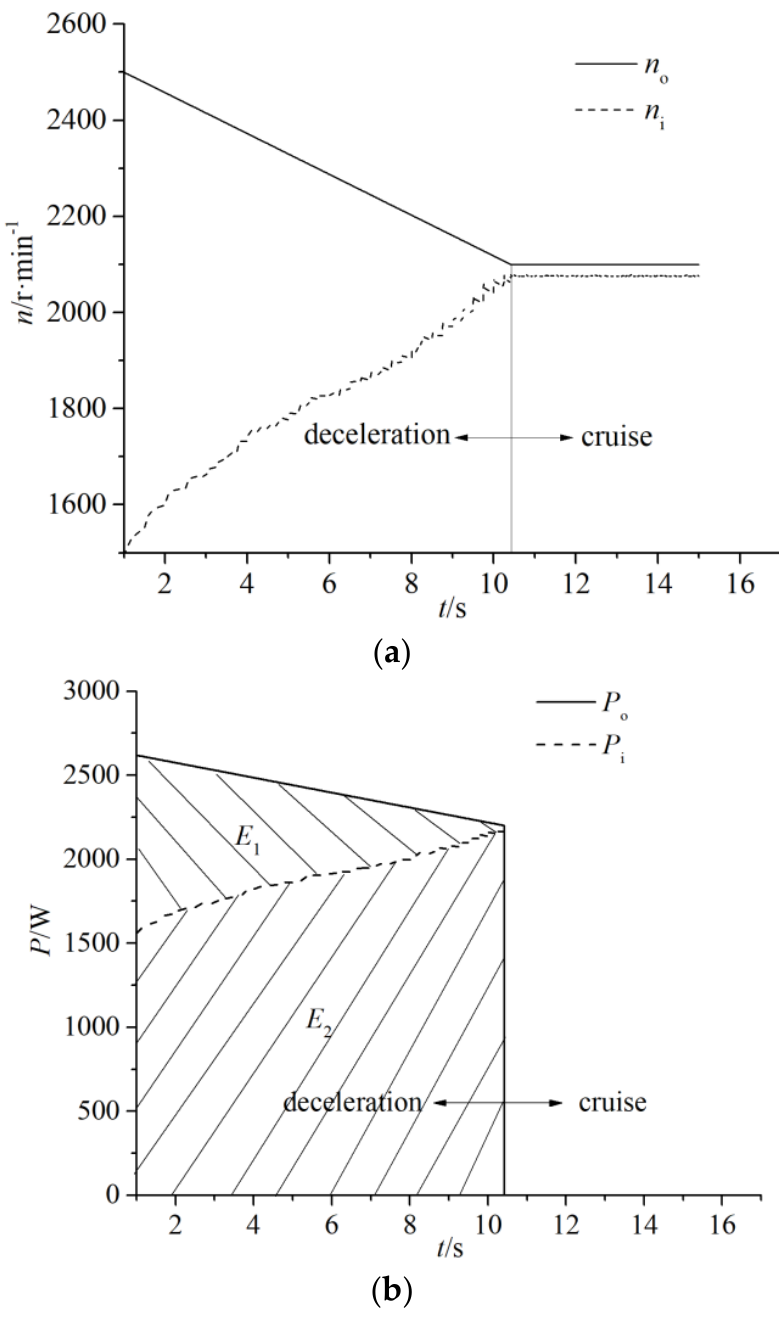
Figure 9. Energy conversion during vehicle deceleration and cruising: ( a ) speed of the coupler mechanical port; ( b ) power of the coupler mechanical port.